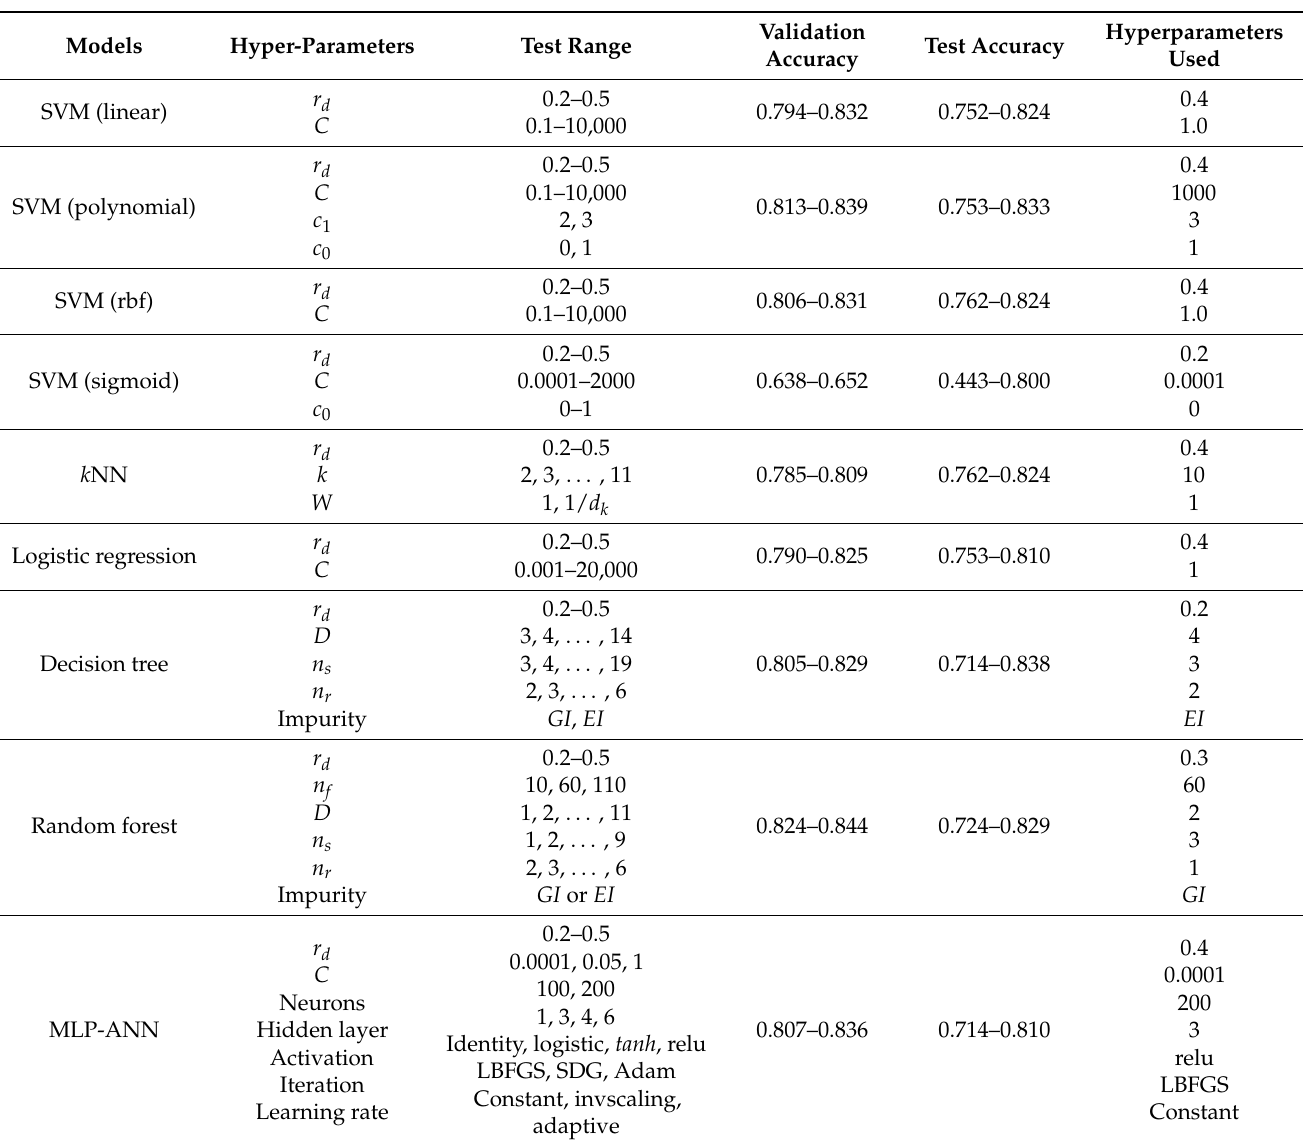
Table 3. Selected machine learning models and hyperparameters for the development of IAQ assessment